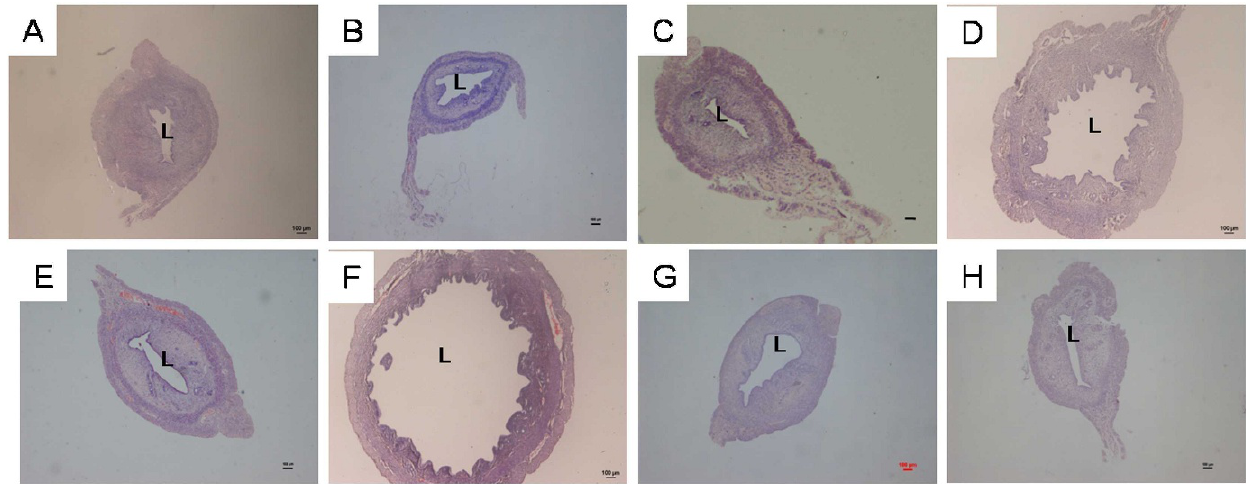
Figure 1 - Representative images of uterine sections from ovariectomised SD rats treated with (A) peanut oil (control), (B) 25G (25 mg/ kg/day genistein), (C) 25G (25 mg/kg/day genistein) + ICI 182780, (D) 50G (50 mg/kg/day genistein), (E) 50G (50 mg/kg/day genistein + ICI 182780), (F) 100G (100 mg/kg/day genistein), (G) 100G (100 mg/kg/day genistein) + ICI 182780, or (H) ICI 182780 (100 m g/kg/day) only for 3 consecutive days. There was a clear increase in the luminal circumference following treatment with 50 and 100 mg/kg/day genistein, although these changes were antagonised by treatment with ICI 182780. Sections were stained with H&E, and the magnification is X4. L indicates the uterine lumen. (G-genistein), n=6 per